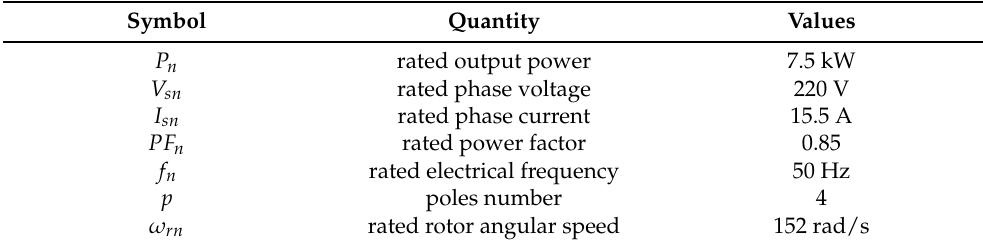
Table 1. Data from the motor